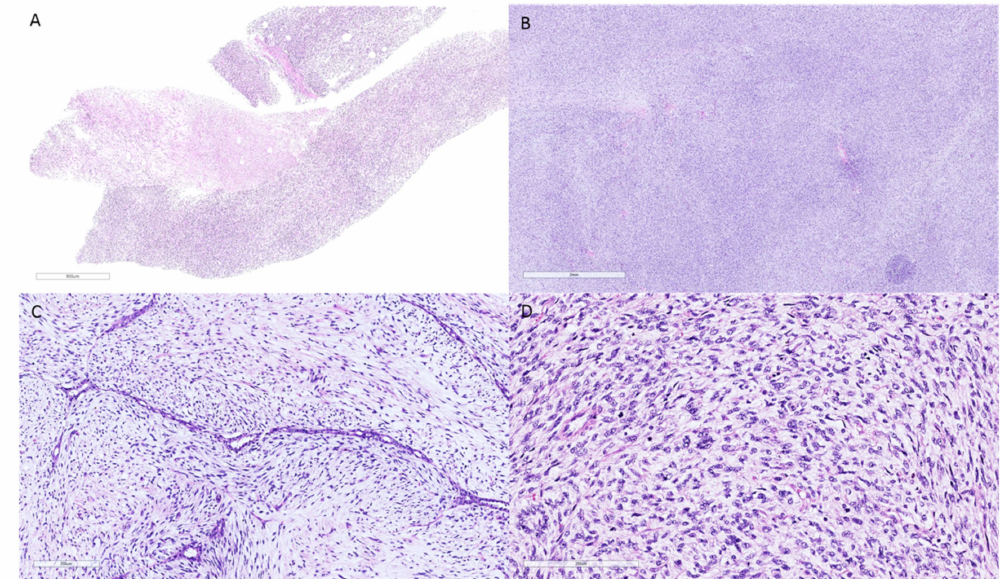
Figure 2. Photomicrographs of the core needle biopsy and surgical excision of a patient initially diagnosed with a malignant spindle cell neoplasm of the breast. ( A ): Core needle biopsy of a malignant spindle cell neoplasm without evident epithelial elements (hematoxylin–eosin, original magnification 10 × ). ( B – D ): Surgical excision of the lesion confirmed the diagnosis of malignant phyllodes tumor, as the presence of a benign epithelial component was demonstrated. ( B ): Tumor areas with diffuse stromal overgrowth and high stromal cellularity (hematoxylin–eosin, original magnification 20 × ). ( C ): Cleft-like spaces covered by benign epithelium with sub-epithelial stromal condensation (hematoxylin–eosin, original magnification 200 × ). ( D ): High magnification of the neoplasm exhibiting a markedly cellular stroma, pleomorphic stromal cells, and numerous mitoses (hematoxylin–eosin, original magnification 200 ×